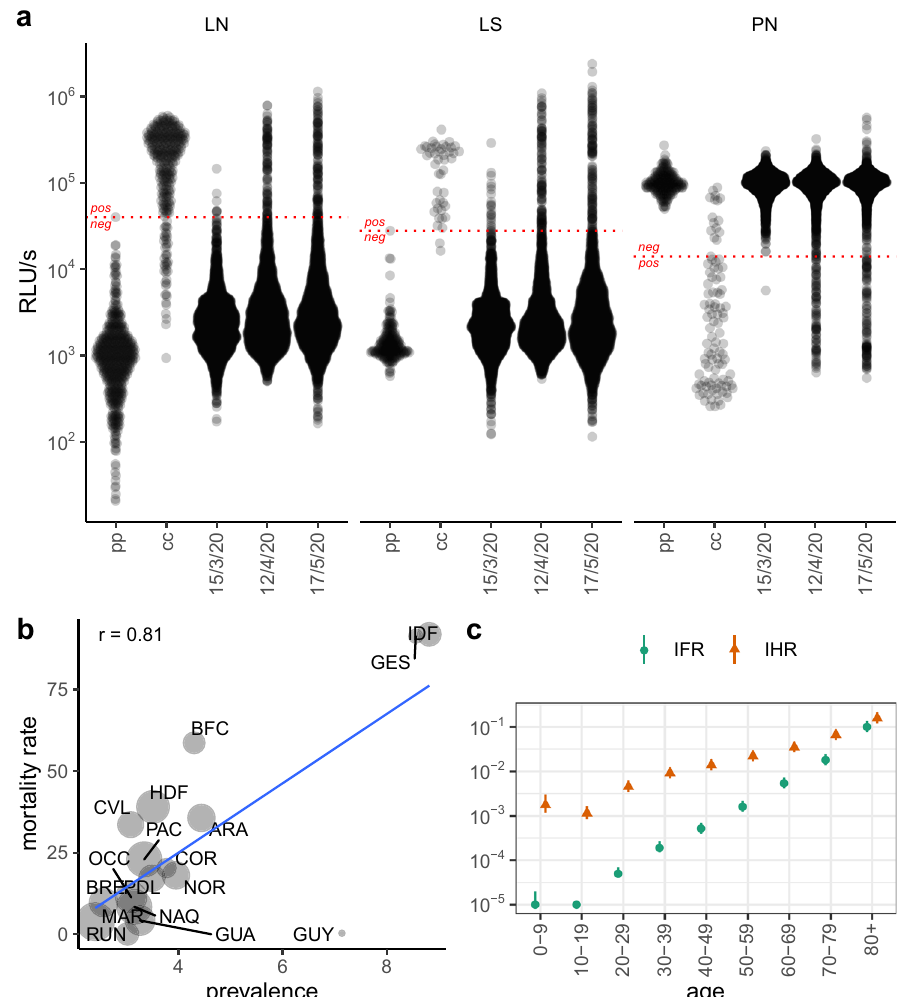
Fig. 2 Serological assay values and population rates derived from prevalence. a Distribution of quantitative values for the LuLISA N, LuLISA S and pseudo-neutralisation assays. Readings in relative light units (RLU in logarithmic scale) are presented for LuLISA N (LN), LuLISA S (LS) and pseudo- neutralisation (PN) assays on sera from pre-pandemic (pp) patients, con fi rmed cases of COVID-19 (cc), and sera sampled during three collection periods the threshold indicate positivity for the LuLISA tests, whereas values below the threshold indicate positivity for the pseudo-neutralisation test. b Weighted correlation between estimated prevalence of SARS-CoV-2 antibodies and reported mortality rates by region. Mortality rates per 100,000 were obtained as region-speci fi c number of deaths attributed to COVID-19 as of 29 May 2020 divided by population size. The date to account for deaths was calculated assuming that individuals with detectable antibodies at sampling time (midpoint of interval from 11 to 17 May 2020) could have been infected at minimum 15 days previously and were susceptible of dying from their infection up to 30 days post-infection. Pearson correlation coef fi cient ( r ) was weighted by standard error of seroprevalence estimates. Circle sizes re fl ect this weighting. Regions are coded as in Fig. 1a. c Infection fatality and infection hospitalisation rates by age. Rates are in logarithmic scale. Infection fatality rate (IFR) is estimated as the cumulative number of deaths per 100 estimated infections strati fi ed by age. Based on available data both from French COVID-19 surveillance and published literature, we considered a lag of 20 days for both time between infection and death, and between infection and seropositivity. Infection hospitalisation rate (IHR) is calculated as the cumulative number of patients hospitalised for COVID-19 per 100 estimated infections strati fi ed by age. We consider a time lag from infection to hospitalisation of 10 days (see “ Methods ”